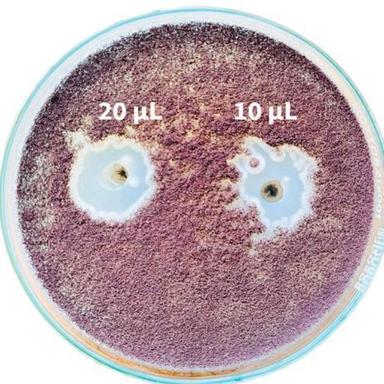
After 48 hours Aspergillus niger was treated with different concentrations of MTZ - ZnMoO4 nanocomposite material in methanol (10 μl and 20 μl).